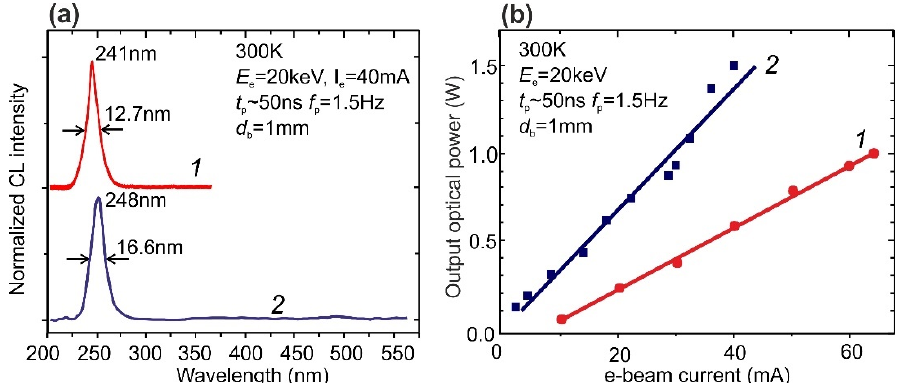
Figure 8. ( a ) Normalized CL spectra at RT of MQW structures with the similar nominal parameters 1 —360 × {GaN 1.5 /AlN 22 }, [29] and 2 —400 × {GaN 1.5 /AlN 16 } (this work). Both spectra were measured using a “high-current” pulsed e-gun with LaB 6 cathode operated at the constant E e = 20 keV and the I e up to 65 mA with t p ~ 50 ns and f p ~ 1.5 Hz. ( b ) Output optical powers vs. the pulse-pumping currents for the ( 1 ) and ( 2 ) MQW structures in ( a ).